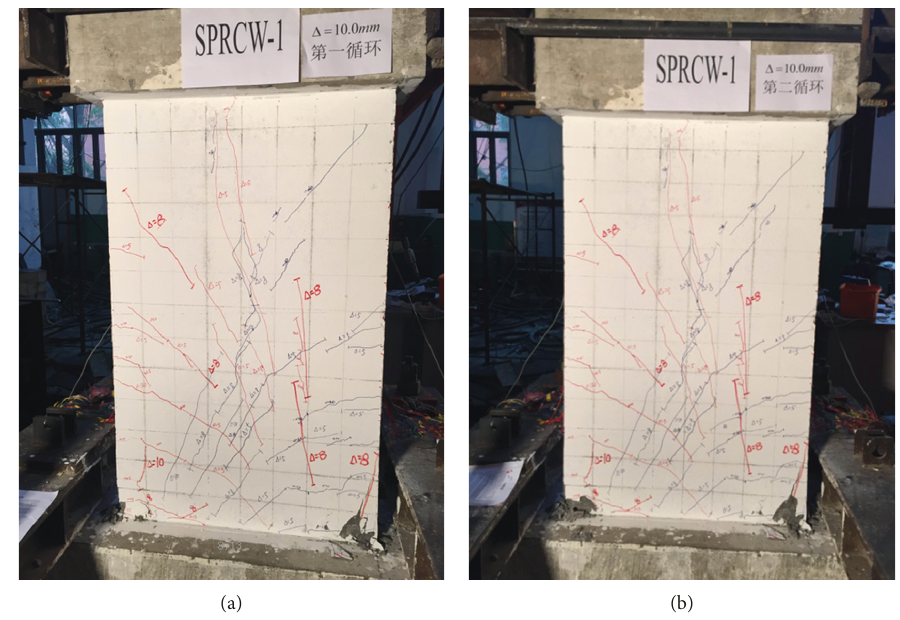
Figure 7: Cracks in the Δ � 10mm displacement cycle. (a) First cycle. (b) Second